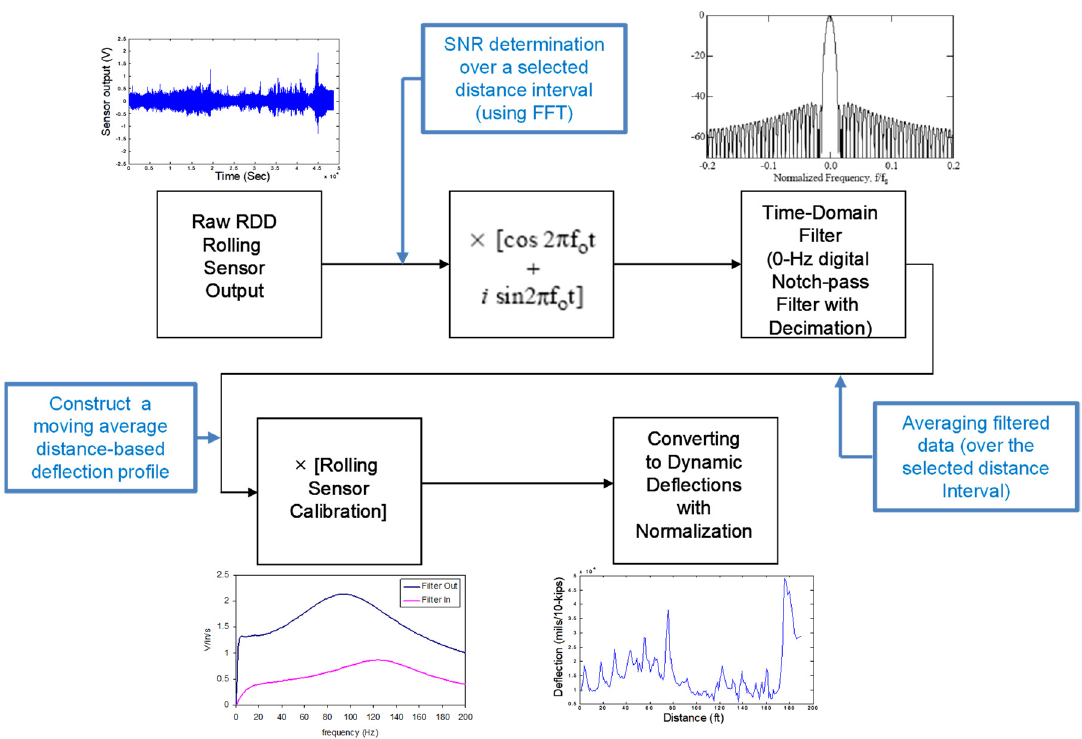
Figure 6. Procedure of new data processing for the speed-improved rolling sensors (note: three additional steps, shown as blue boxes, were added for the new data processing).